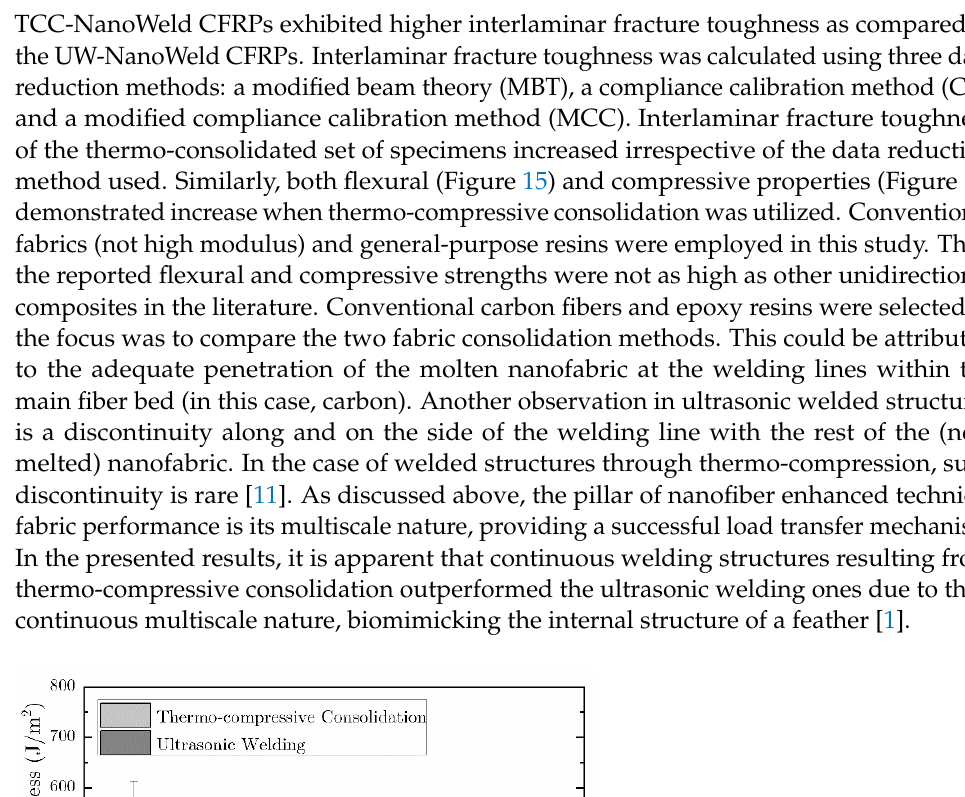
Figure 15. Comparison plots of ( a ) flexural modulus (GPa) and ( b ) flexural strength (MPa), measured for CFRP specimens prepared via thermo-compressive consolidation and ultrasonic welding. Figure 16. Plots of the CFRPs’ compressive strength measured for thermo-compressive consolida- tion and ultrasonic welding.